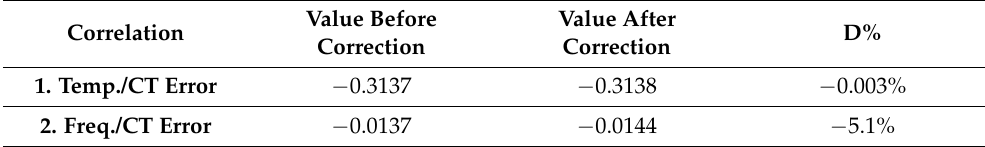
Table 7. Relations of